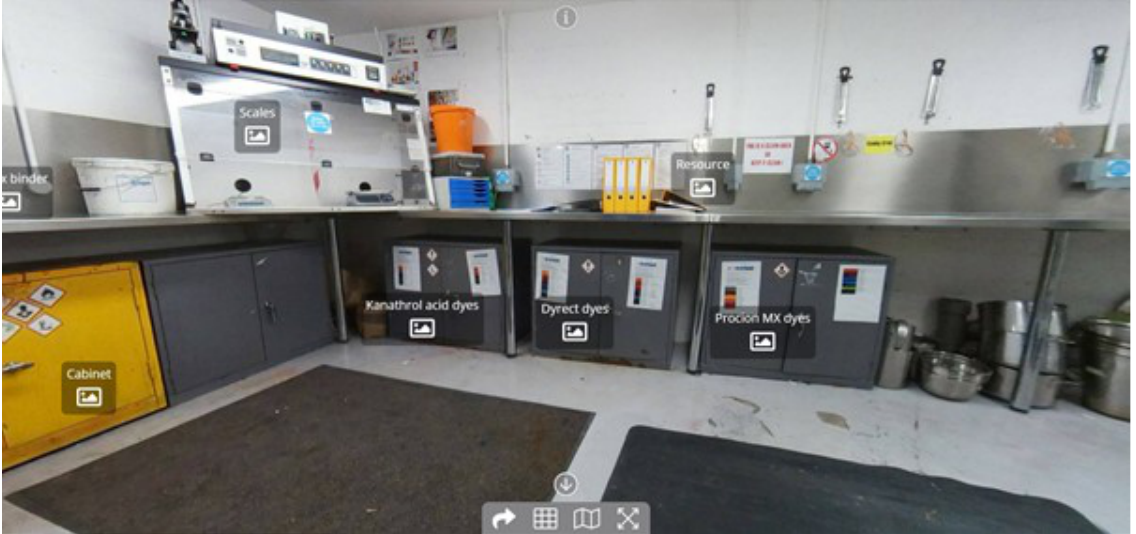
Seekbeak ® 360° Room: Washroom in the Art and Design